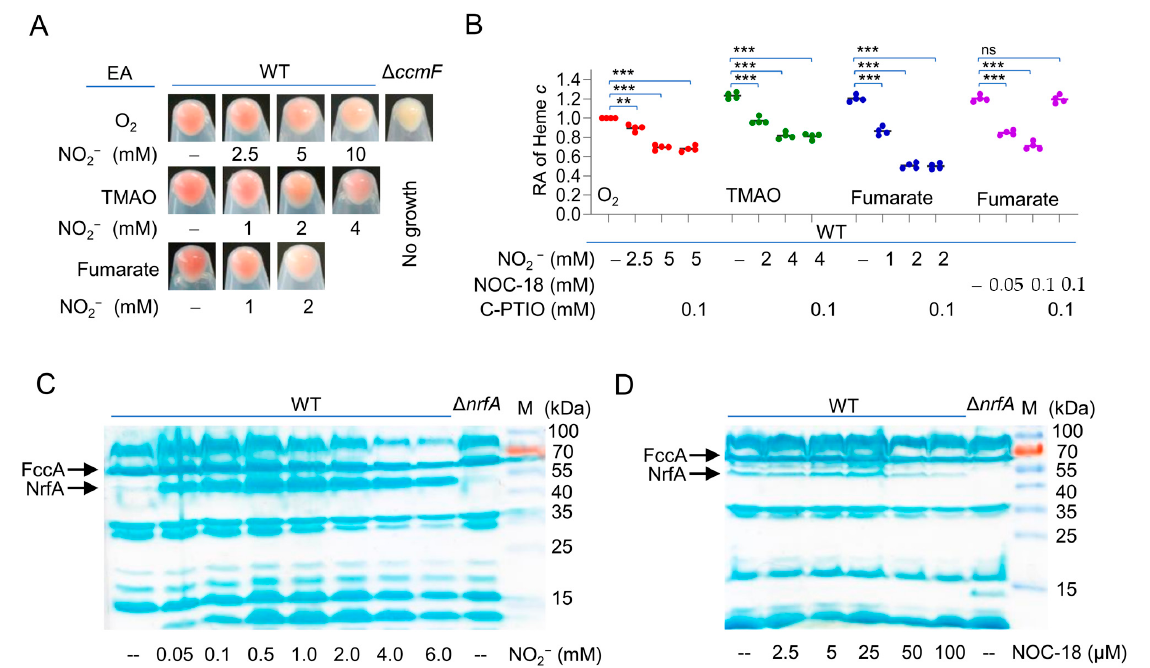
Figure 1. Nitrite and NO down-regulate cyt c content of S. oneidensis . ( A ) The cell color phenotypes. Shown are cell pellets of indicated strains grown on one of the EAs, O 2 , TMAO, and fumarate, to the early stationary phase. Strains include the wild-type (WT) and cyt- c -deficient ∆ CcmF . ( B ) Heme c levels. Samples prepared as in ( A ) were lysed for quantification of heme c . NOC-18 and C-PTIO were used as the NO producer and scavenger, respectively. The data were first adjusted to the protein levels of the samples, and then, the averaged heme c levels of the mutants were normalized to that in the WT, which was set to 1, giving the relative abundance (RA). Asterisks indicate statistically significant difference of the values compared ( n = 4; ns, not significant; **, p < 0.01; ***, p < 0.001). ( C , D ) Heme staining. Samples prepared the same as for the quantification of heme c were processed; the protein contents were quantified, and equal amounts of the proteins were separated in SDS-PAGE, then subjected to heme staining. M, molecular weight marker. FccA and NrfA are indicated by arrows. All experiments were performed three times, and representatives as in ( A , C , D ) are presented.